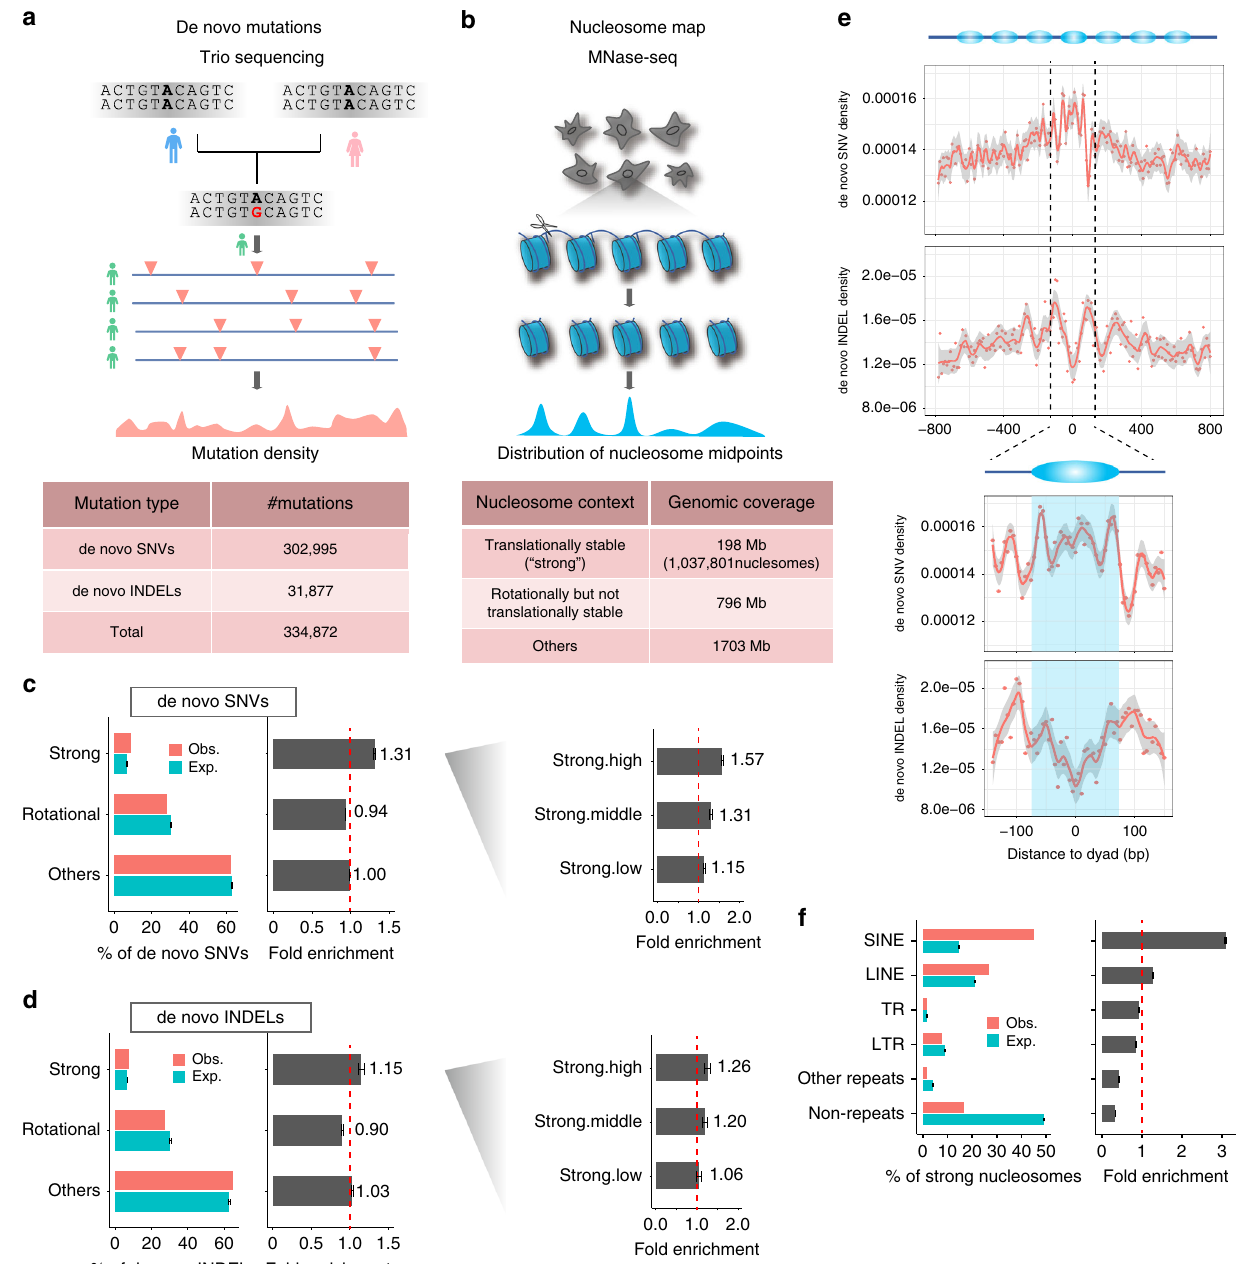
Fig. 1 De novo mutations are enriched in strong nucleosomes. a Summary of germline de novo mutation data included in study. b Summary of nucleosome positioning data analyzed in study. Observed vs. expected occurrence and fold enrichments of de novo c SNVs and d INDELs in the three different nucleosome contexts. Right-hand panel subdivides strong nucleosomes according to high, medium, and low translational stabilities. Error bars depict 95% con fi dence intervals. e Top panels, meta-pro fi les of de novo SNV and INDEL densities relative to position of strong-nucleosome dyads (negative values in x axis representing upstream positions). Bottom panel, same meta-pro fi les zoomed into the middle nucleosome. f Fold enrichment of strong nucleosomes in different repeat elements: short interspersed nuclear element (SINE), long interspersed nuclear element (LINE), tandem repeat (TR), and long terminal repeat (LTR). Source data are provided as a Source Data fi